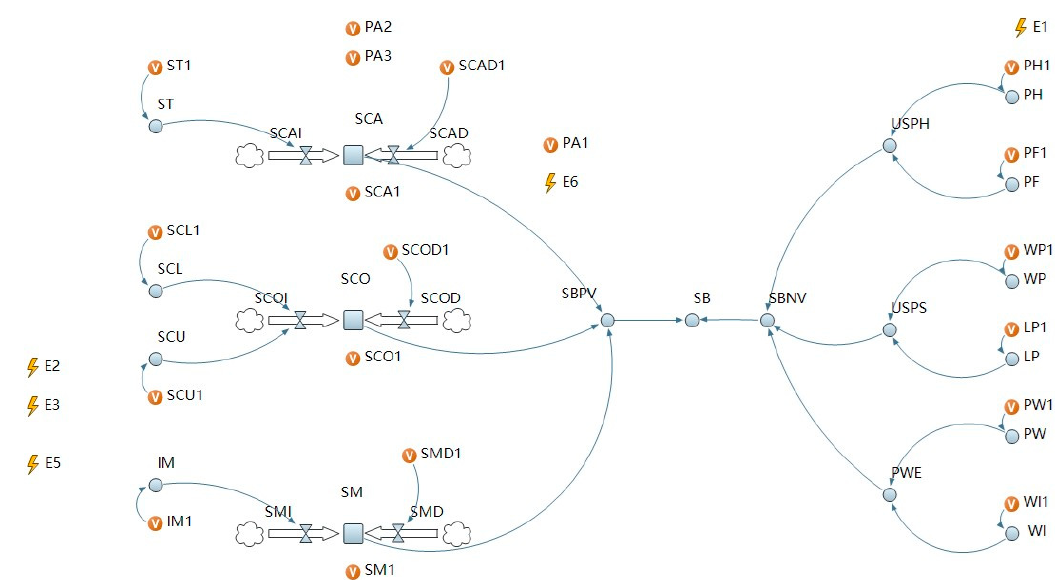
Figure 3. The active intervention simulation model of unsafe behavior of construction workers. ST = Safety training, SCL = Safety climate, SCU = Safety culture, IM = Incentive mechanism, SCA = Safety capability, SCO = Safety consciousness, SM = Safety motivation, SB = Safety behavior, USPH = Unsafe physiology, USPS = Unsafe psychology, PWE = Poor work environment, PH = Physical handicap, PF = Physical fatigue, WP = Work pressure, LP = Life pressure, PW = Poor workplace, WI = Work intensity, PA i = Parameter i ( i = 1,2,3), E i = Event i ( i = 1,2,3,4,5,6,7), SBPV = the positive values of SB, SBNV = the negative values of SB, SCAI (SCOI, SMI) = the increment of SCA (SCO, SM, SB), SCAD (SCOD, SMD) = the decrement of SCA (SCO, SM, SB)).